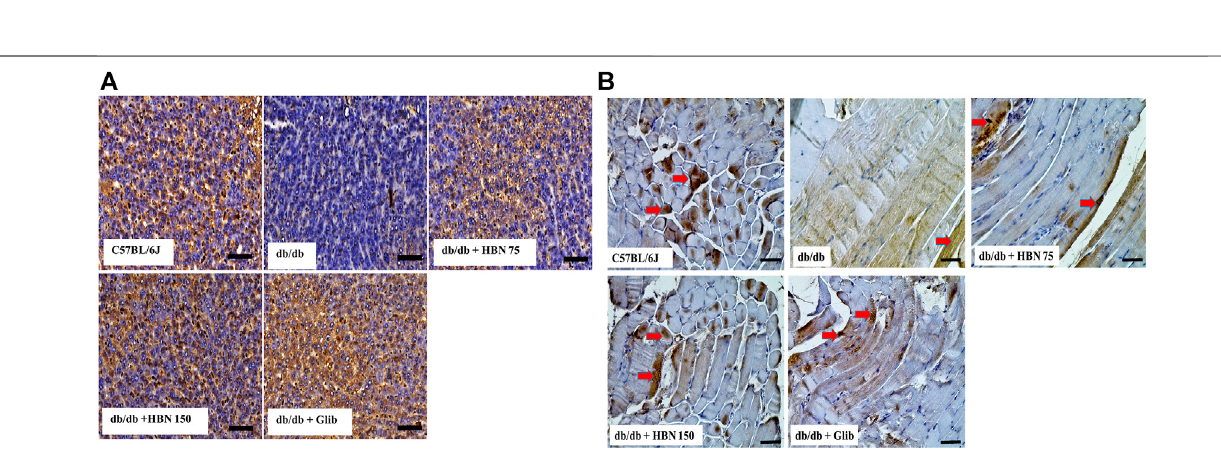
Frontiers in Pharmacology |